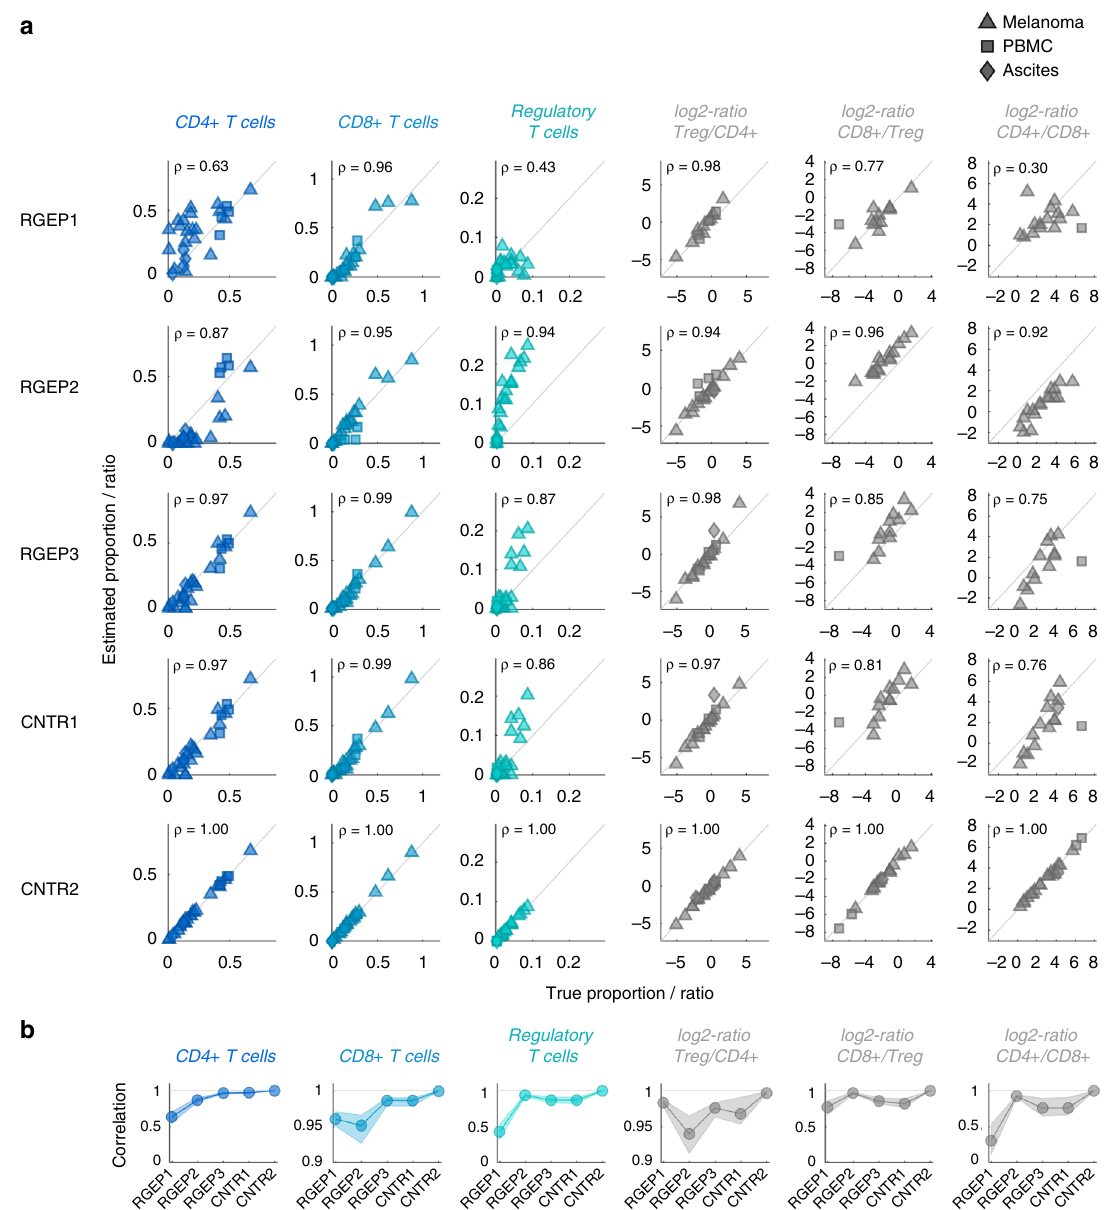
Fig. 5 Estimation accuracy of T cell subsets within the T cell population and clinically relevant ratios of T cells and their dependence on the origin and quality of RGEPs. a Scatter plot of true and estimated cell proportions for all 27 patient samples. Each dot represents one patient sample. Values close to the diagonal correspond to high deconvolution accuracy. Columns depict cell types; rows describe the fi ve different con fi gurations (REGP1-3 and CNTR1-2). ρ denotes the Pearson ’ s correlation coef fi cient. In con fi guration REGP1, estimates for tumour-associated cell types are not available. b Pearson ’ s correlation coef fi cient between estimated and true cell fraction for all fi ve con fi gurations. Dots denote the median of the correlation coef fi cient; the shading represents the uncertainty based on bootstrapping (upper and lower quartile). (Please note the different scaling of the fi gure